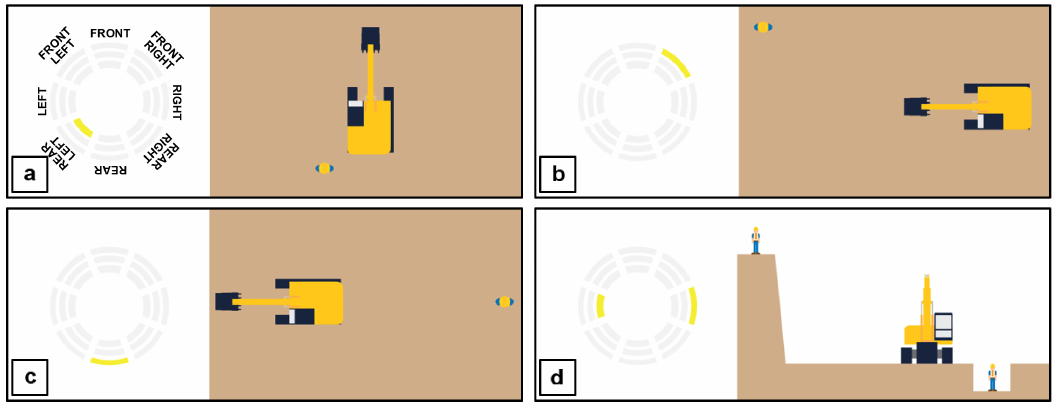
Figure 15. The proximity warning concept that has been revised by rearranging the areas that are represented by each segment, as shown in the top-left image, and removing the segments that indicate the obstacle’s altitude in order to avoid confusion. The inner, middle, and outer segments respectively indicate something that exists near (within 1 radius of the machine), medium (2 radii), and far (3 radii) from the machine. ( a ) There is an obstacle near rear left of the machine. ( b ) There is a far obstacle in the front left of the machine. ( c ) There is a far obstacle exactly behind the machine. ( d ) There are two obstacles on both left and right sides of the machine, but this concept no longer indicates the altitude of the